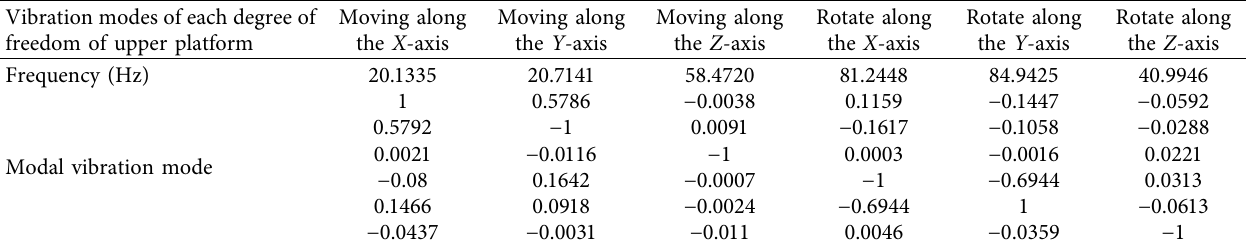
Table 4: Modal frequencies and corresponding modal shapes of the Stewart platform in Case (c). Vibration modes of each degree of Moving along freedom of upper platform